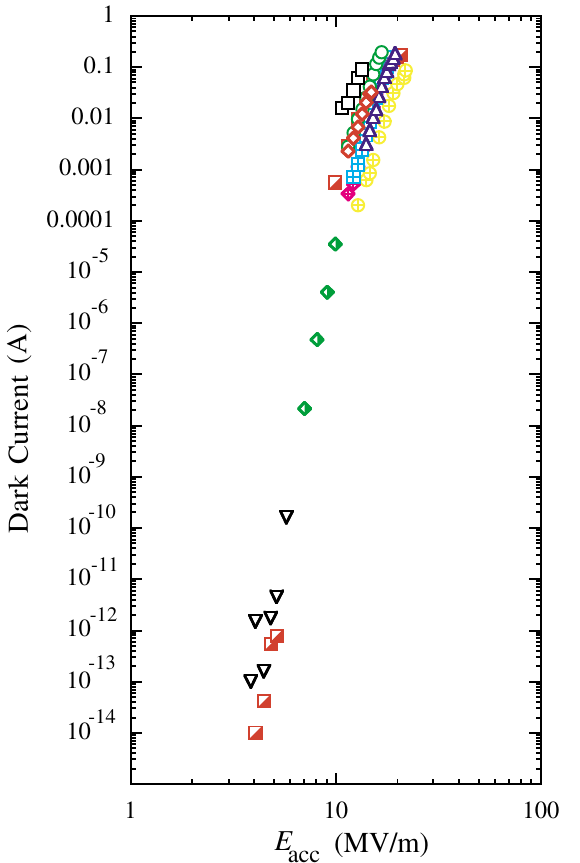
FIG. 3. (Color) Dark current measurements. Data points are identified in Fig. 5, except for low current points taken on August 24 and 28.